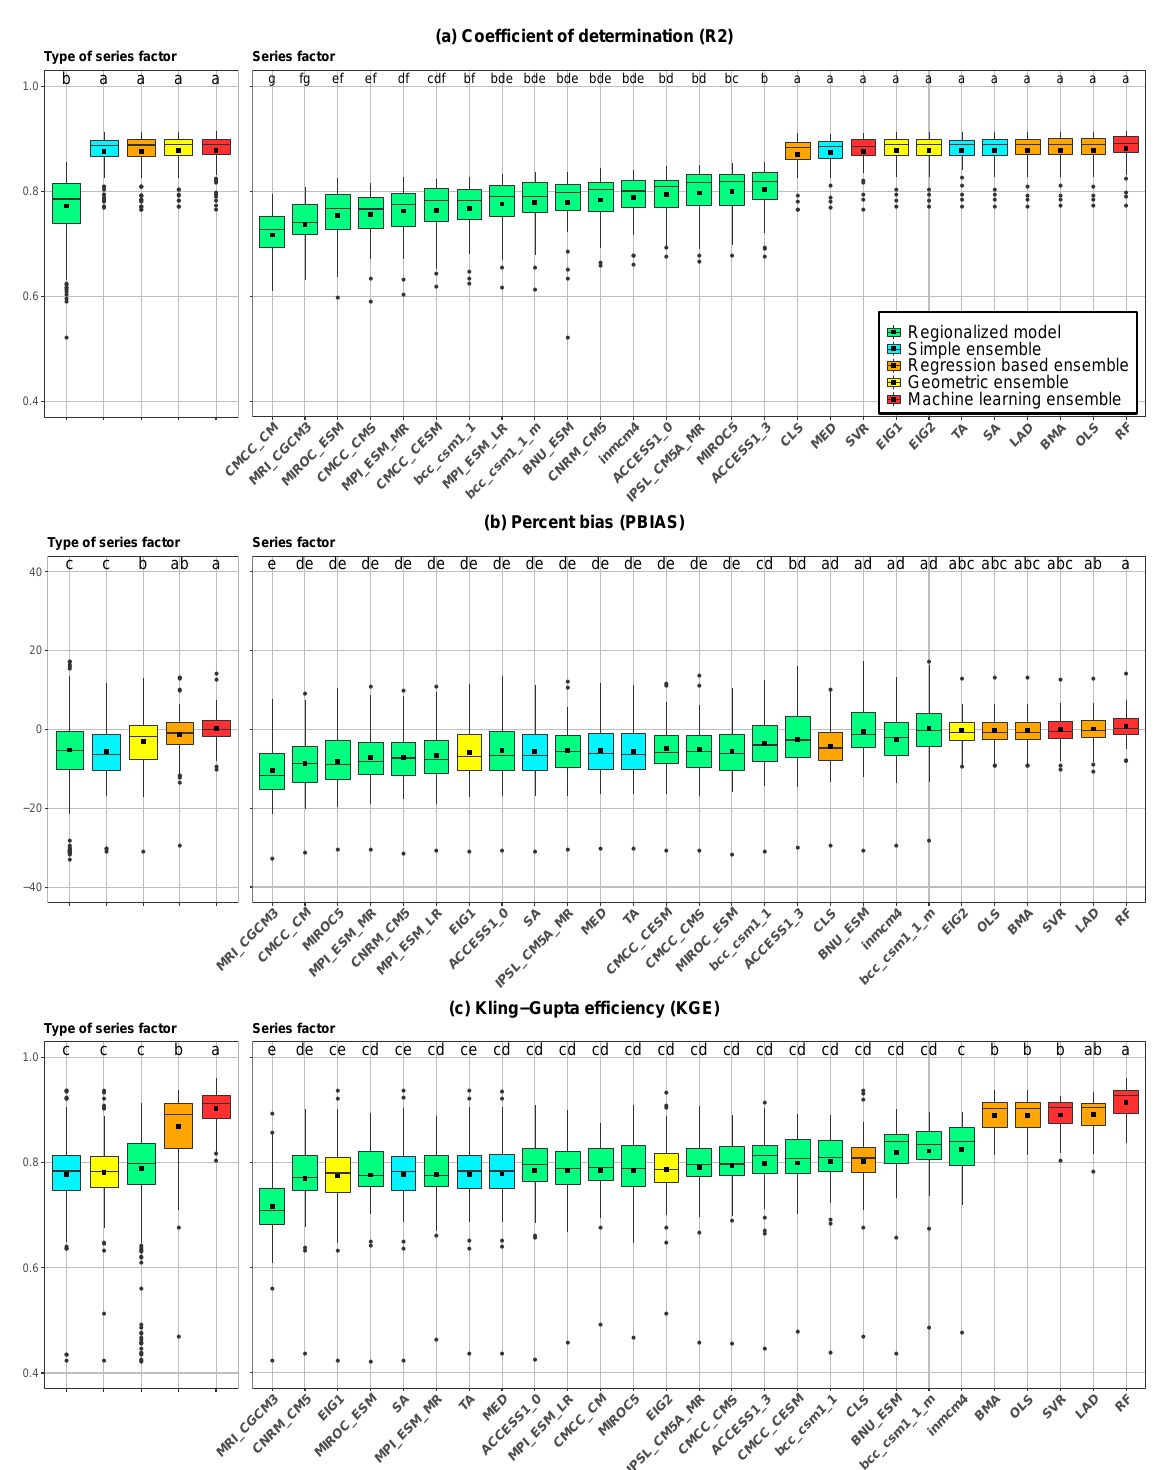
Figure 3. Distributions of ( a ) coefficient of determination ( R 2 ), ( b ) bias percentage (PBIAS), and ( c ) Kling–Gupta efficiency (KGE) in validation by stations ( N = 48 stations × 27 series = 1296 observations). Grouped by individual series ( right ) and by the type of series ( left ). Significantly different groups (Tukey-–Kramer contrast using heteroscedasticity-consistent covariance matrix of the parameters (HC3), alpha = 0.05) are represented by different letters. Post hoc contrasts for PBIAS were calculated with absolute